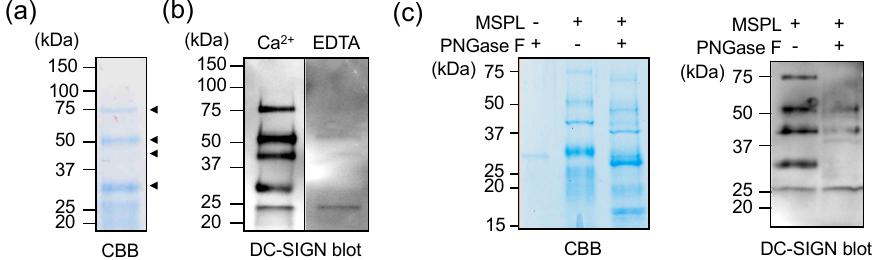
Figure 3. Ca 2 + -dependent recognition of MSPL by DC-SIGN. ( a ) The extracellular domain of human MSPL (MSPL–ECD(extracellular domain)) with a C-terminal FLAG-tag was expressed in human hepatoma HLF cells. The secreted MSPL was purified and separated through sodium dodecyl sulfate–polyacrylamide gel electrophoresis (SDS–PAGE) under reducing conditions and detected through Coomassie Brilliant Blue (CBB) staining. ( b ) The extracellular domain of DC-SIGN (DC-SIGN–ECD) was prepared and applied to DC-SIGN lectin blotting. MSPL–ECD blotted on a nitrocellulose membrane was reacted with DC-SIGN–ECD in the presence of Ca 2 + or EDTA. ( c ) The purified MSPL–ECD was pretreated with PNGase F for 24 h at 37 ◦ C and then subjected to DC-SIGN lectin blotting.